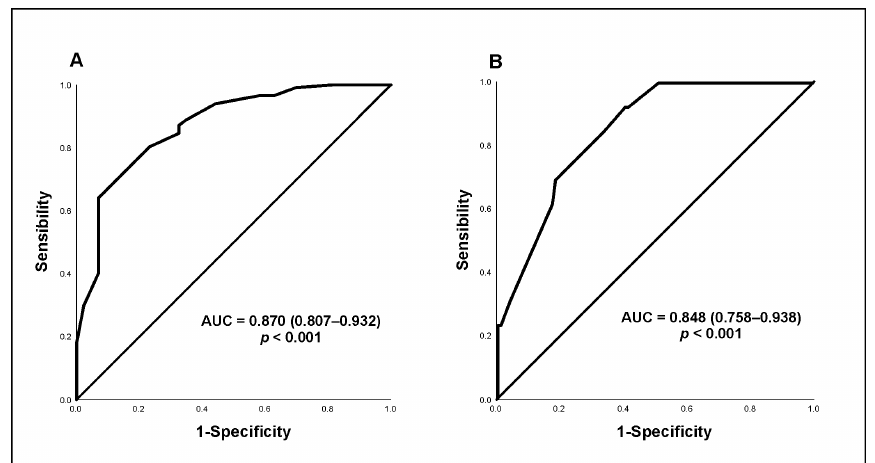
Figure 1. Receiver operating characteristic (ROC) curve for clinical prediction model of NAFLD ( A ) and advanced fibrosis ( B ).